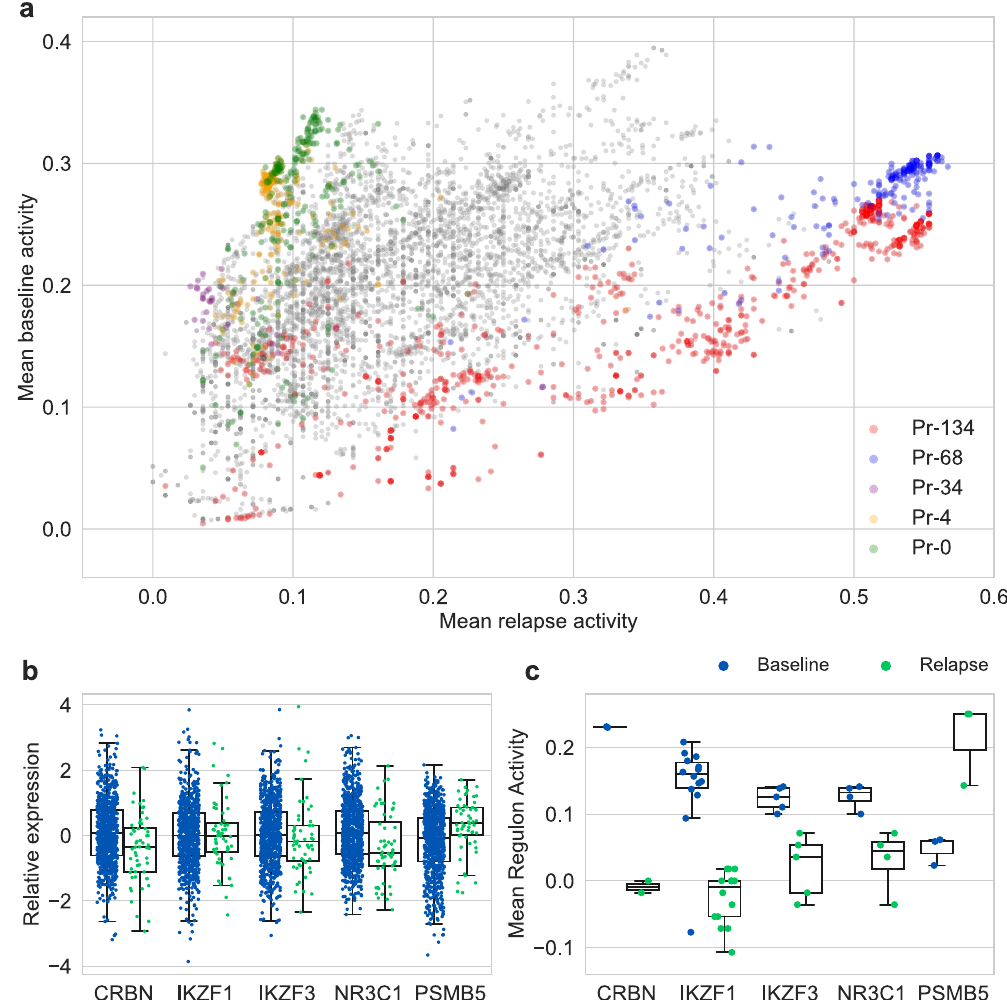
Fig. 6 Network activity of genes at baseline versus relapse. a Each point depicts the mean network activity of a gene at relapse versus baseline. The genes of programs Pr-134, Pr-68, Pr-34, Pr-4, and Pr-0 are highlighted. b , c Boxplots of ( b ) gene expression and ( c ) mean regulon activity at baseline and relapse for target genes of baseline therapy (IMiDs: CRBN , IKZF1 , IKZF3 ; dexamethasone: NR3C1 ; car fi lzomib: PSMB5 ). Center line, median; box limits, upper and lower quartiles; whiskers, 1.5× interquartile